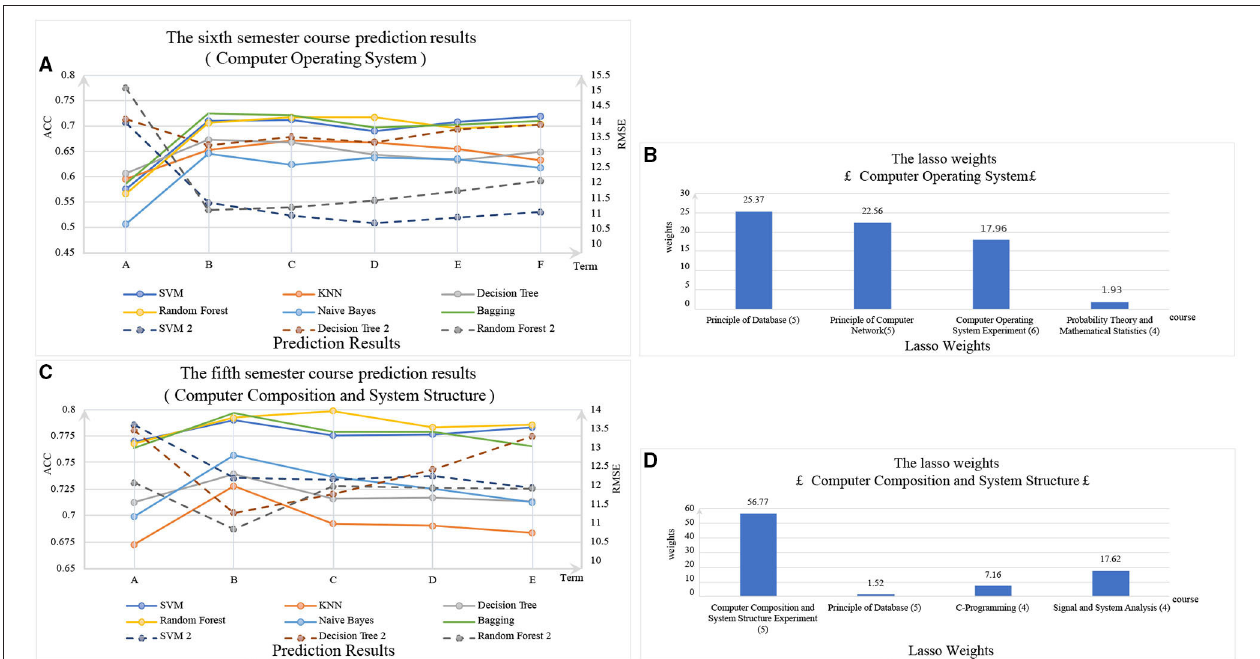
FIGURE 3 | In (A,C) : The solid lines are classification methods, and ACCs are marked on the left primary axis as the evaluation metric. The dotted lines are regression methods, and RMSEs are marked on the right secondary axis as the evaluation metric. In (B,D) : The x-axis is the course whose weights are not zero after the feature selection by Lasso, and (*) represents the semester of the course. The y-axis is the weight of the